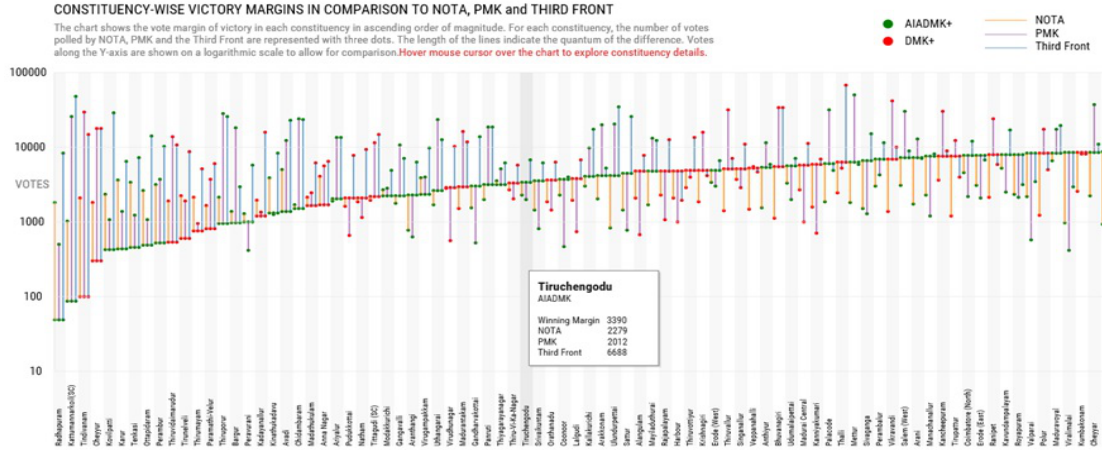
Figure 10: Combined Graph for Winning Margin and Effect of NOTA, PMK and Third